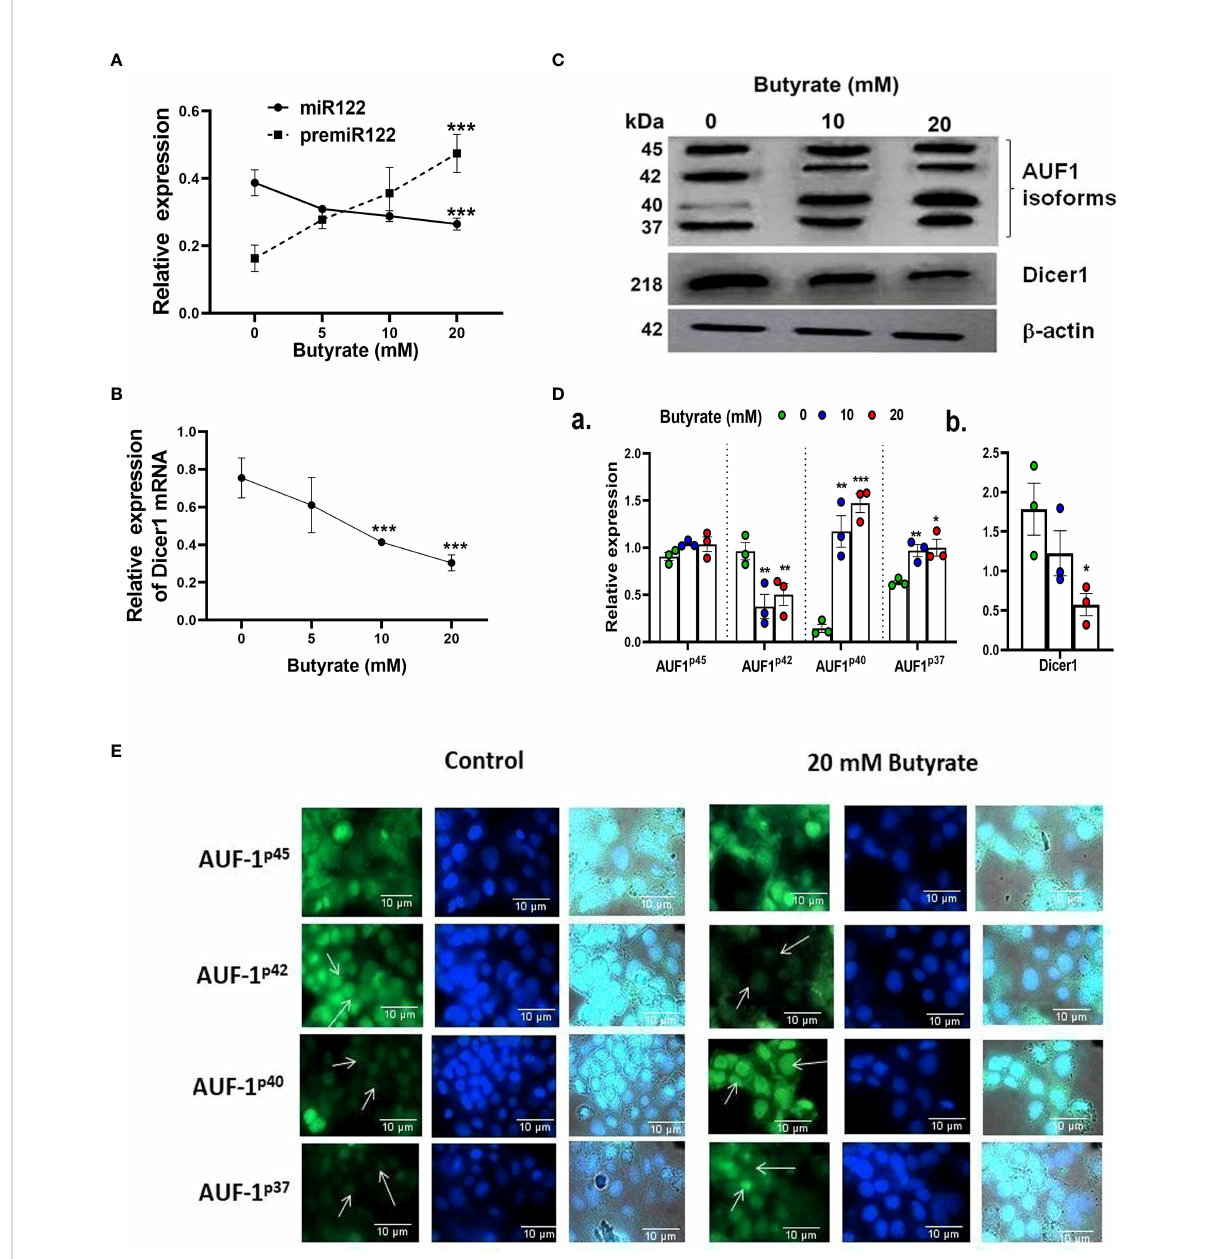
FIGURE 3 Effect of butyrate on miR122 maturation, Dicer1 expression, AUF1 isoform expression by Western blot, and EGFP reporter assays in Huh7 cells. Expression of pre-miR122 and miR122 (A) and Dicer1 (B) as determined by qPCR and Western blot of AUF1 isoforms (upper panel) and Dicer1 protein (middle panel) as a function of butyrate concentration (C) and corresponding densitometry of AUF1 isoforms (AUF1 p45 /AUF1 p42 /AUF1 p40 / AUF1 p37 ) (D, a) and Dicer1 (D, b) with respect to b -actin control using ImageJ. Transfection of Huh7 cells with individual AUF1 isoforms of EGFP reporter construct (pEGFP-AUF1 p45 or pEGFP-AUF1 p42 or pEGFP-AUF1 p40 or pEGFP-AUF1 p37 ) in the absence and presence of 20 mM butyrate for 24 h (E) . The resulting fl uorescence images are taken under 60× in Apotome Zeiss microscope with a CCD camera controlled with ZEN software (Carl Zeiss, Gottingen, Germany). N = 3. The data are presented as mean ± SE. *** represents p < 0.001, ** represents p<0.01, * represents p <